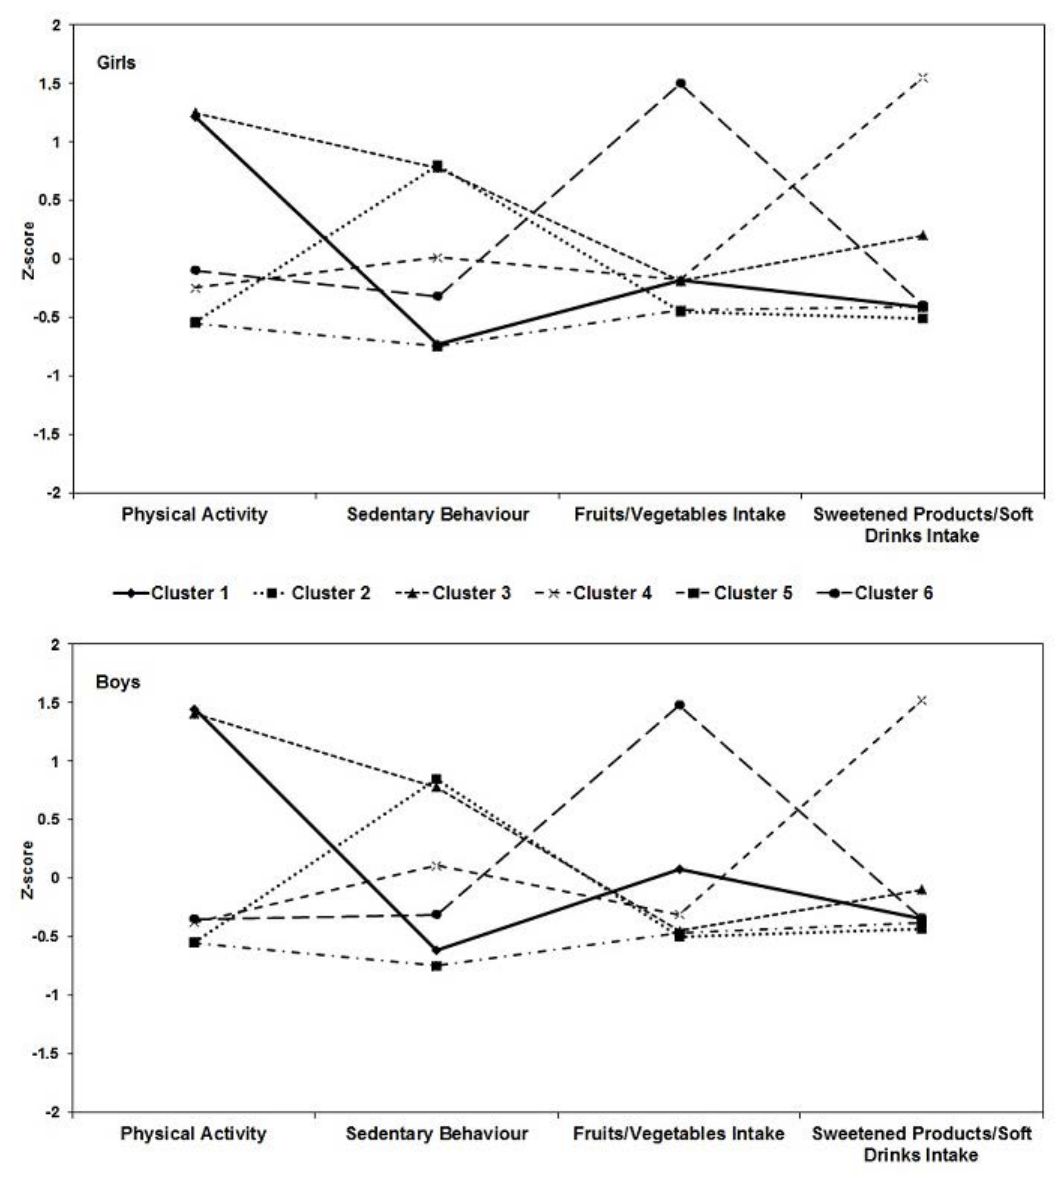
Figure 1. Cluster solutions and mean z scores of multiple lifestyle behaviors related to excess body